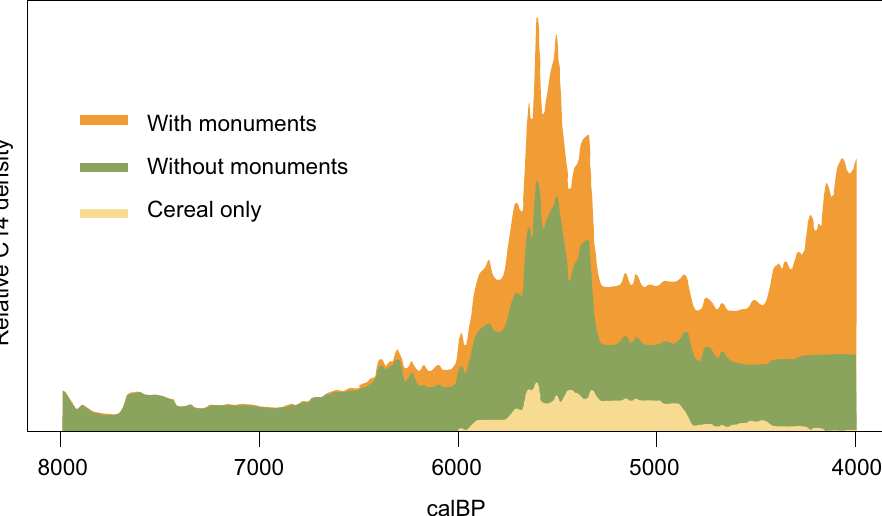
Fig. 1: Summed radiocarbon probability distribution for dates from Britain between 8000 and 4000 cal. BC. The procedure for producing the distribution is described in the text. Dates from all sites including monuments (burial mounds and earthwork enclo- sures) are distinguished from those from non-monumental sites; the dates from cereal grains indicate that the rise in population inferred from the distribution is associated with the beginning of farming (from Collard et al .,